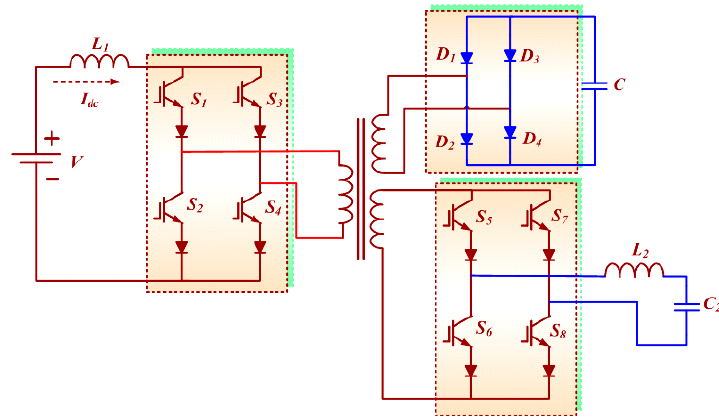
Figure 15. Power decoupling solution with three-port circuit [43].